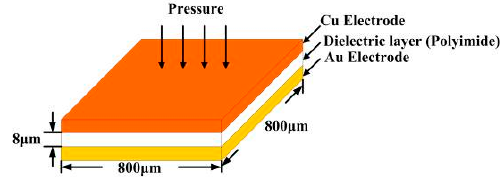
Figure 3. Design of capacitive micro pressure sensor.